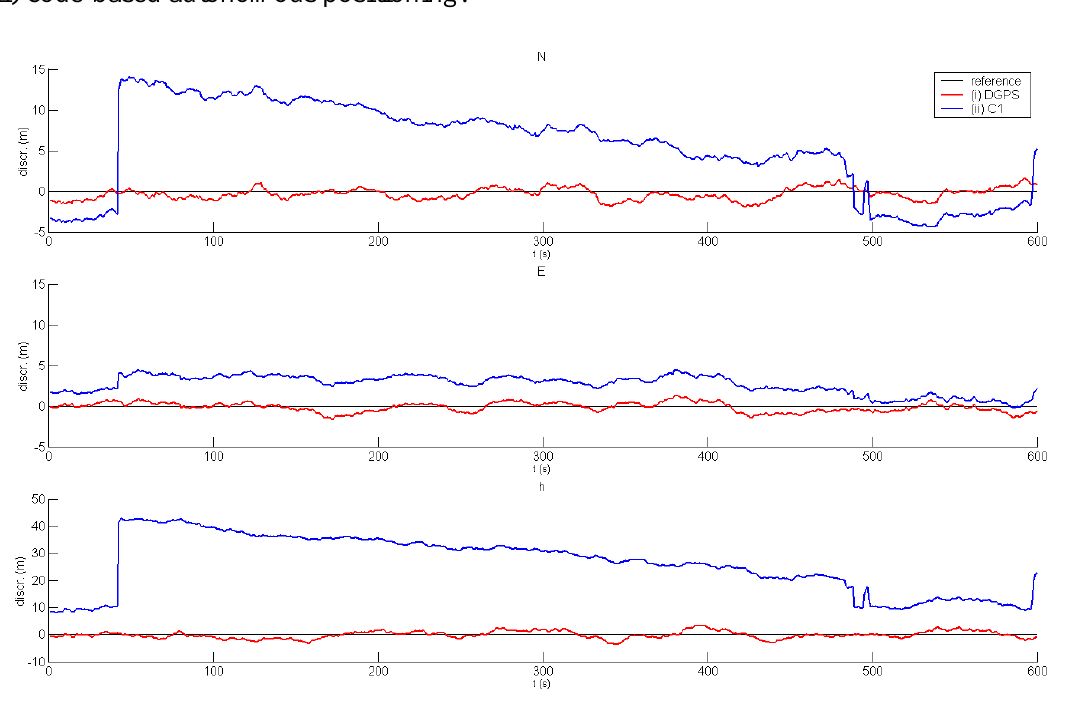
Figure 3. Performance of DGPS under normal conditions: (i) DGPS positioning; (ii) code-based autonomous